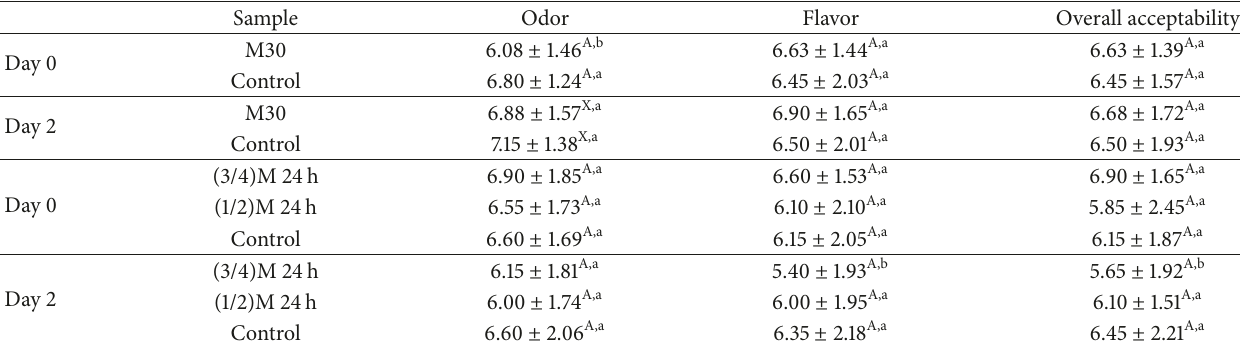
Table 3: Sensory evaluation results (mean ± standard deviation) obtained for tomatoes treated with the minimal inhibitory concentration (MIC) of mustard essential oil (3.08 𝜇 L/L ) for 30 min (M30) or selected MIC proportions ((3/4)M or (1/2)M) of mustard essential oil for air 24